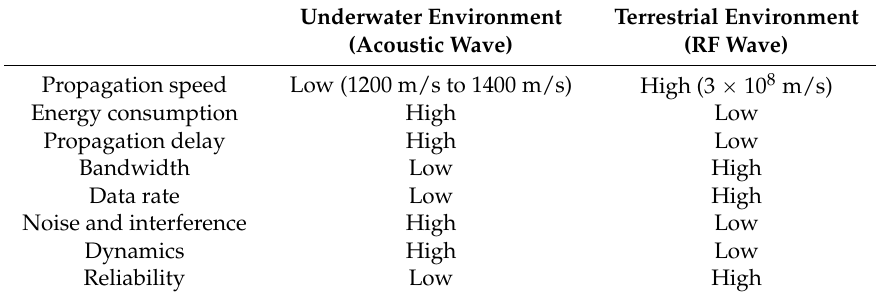
Table 1. The differences between the underwater environment and the terrestrial